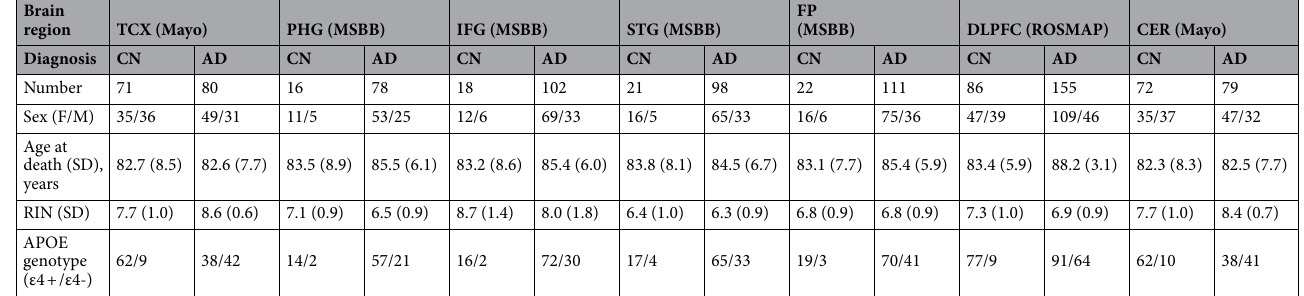
Table 1. Demographic and clinical characteristics of cognitively normal (CN) and Alzheimer disease (AD) participants for different brain region analysed. TCX temporal cortex, PHG para-hippocampal gyrus, IFG